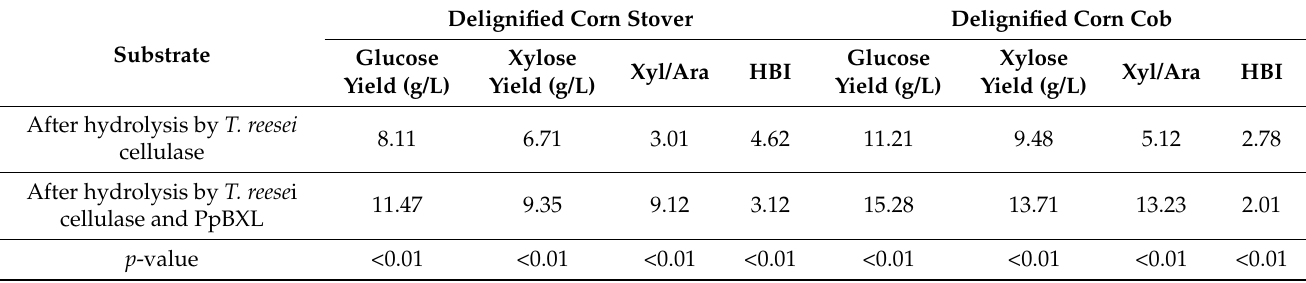
Table 3. Biomass characteristics and saccharification before and after PpBXL